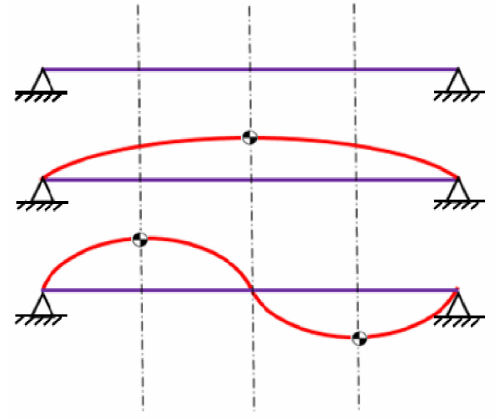
Figure 2. Modal shapes of simply supported rotors.